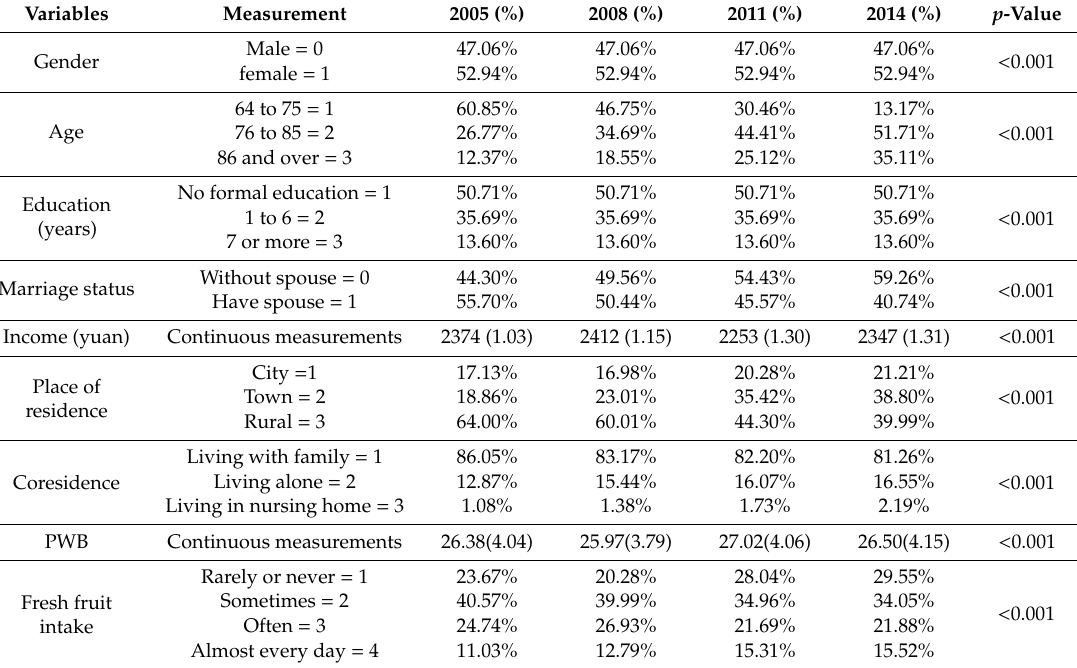
Table 2. Descriptive statistics for study